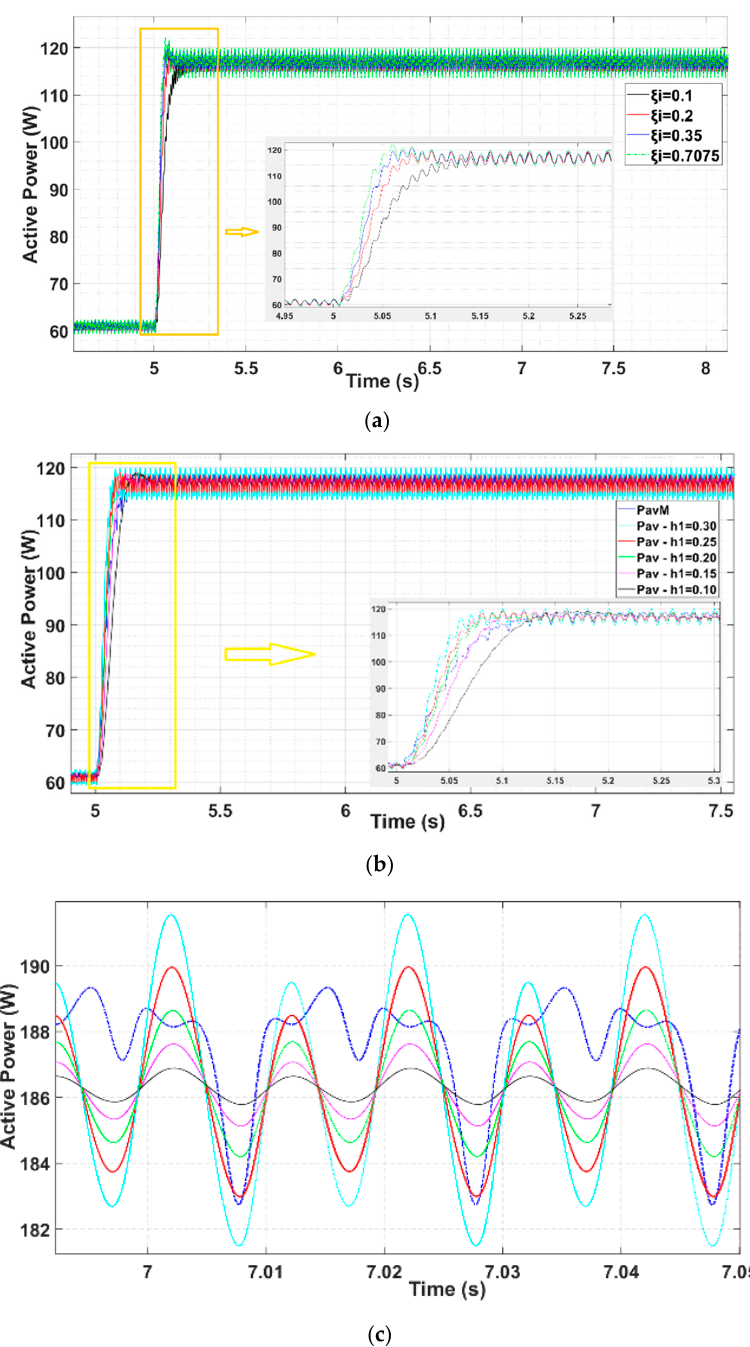
Figure 8. A family of Pav plots after varying its control parameters: ( a ) plot of the proposed calculation of active power, varying the damping factor of SOGI0 and keeping constant h 1 = 0.25 and the damping factors of SOGI1 and SOGI2 at 𝜉 (cid:3043) = 0.7075 ; ( b ) Pav varying ℎ (cid:2869) from 0.1 to 0.30 with 𝜉 (cid:3036) = 0.2 and 𝜉 (cid:3043) = 0.7075, PavM in blue dot line, and Pav during the transient step load; ( c ) steady-state ripple for each calculated Pav , compared with PavM (blue dot line).